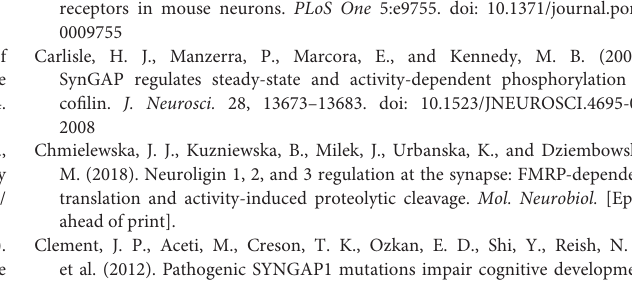
HET: N = 3) and PND21-23 ( right , WT: N = 3; HET: N = 3); NS, not significant. Unpaired Student’s t -test. FIGURE S5 | Dysregulated NMDAR-mediated translation response is recovered during PND21-23 in HET. (A) Representative immunoblot for Phospho-eEF2 and Total-eEF2 showing increased phosphorylation on NMDAR stimulation for 1-min in synaptoneurosomes from WT during PND21-23 ( left ). Pooled data of the same represented in the bar graph ( right, Basal: N = 4; Stimulated: N = 4); ∗ p < 0.05; Unpaired Student’s t -test. (B) Representative immunoblots of phospho- and total-eEF2 normalized to β -ACTIN during PND14-16 in WT and HET ( top ). The bar graph shows increased phosphorylation of eEF2 at basal conditions in synaptoneurosome obtained from the hippocampus of HET as compared to WT during PND14-16 in the ( middle, WT: N = 4; HET: N = 3). Bar graph showing decreased phosphorylation of eEF2 in HET on NMDAR stimulation as compared to WT in PND14-16 ( below, WT: N = 4; HET: N = 4). ∗ p < 0.05, ∗∗ p < 0.01; Unpaired Student’s t -test; WT and HET samples were run on the same gel; 1-min stimulation blots were cropped and showed here. (C) Representative immunoblots for phospho-eEF2 and total-eEF2 normalised to β -ACTIN during PND21-23 in WT and HET ( top ). Increased phosphorylation of eEF2 at the basal condition in HET synaptoneurosome as compared to WT during PND21-23 ( middle , WT: N = 3; HET: N = 3). Bar graph showing the extent of phosphorylation in HET is similar to WT during PND21-23 ( bottom , WT: N = 3; HET: N = 4). ∗ p < 0.05, NS, not significant; Unpaired Student’s t -test. (D) Representative immunoblot for Phospho-ERK1/2 and Total-ERK1/2 showing increased phosphorylation on NMDAR stimulation for 5-min in synaptoneurosomes from WT and HET during PND14-16 ( left ). Pooled data of the same represented in the bar graphs ( right, Basal: N = 4; Stimulated: N = 4); ∗ p < 0.05; Unpaired Student’s t -test. FIGURE S6 | Altered phosphorylation of eEF2 in HET. (A) Representative immunoblot depicting the enrichment of PSD-95 in synaptoneurosome (S) compared to Total hippocampal lysate (T; top ). A bar graph is showing quantified data normalised to α -TUBULIN ( below ). (B) Representative immunoblot for Phospho-eEF2, Total-eEF2, and β -ACTIN in synaptoneurosomes after 1-min stimulation with NMDA, AP-5, and NMDA + AP-5 ( top ). Quantified data as histogram shows increased phosphorylation of eEF2 on NMDA treatment is lost when co-treated with AP-5 ( below ). ∗ p < 0.05, One-way ANOVA followed by Dunnett’s multiple comparison tests. (C) Representative immunoblot images for Phospho-eEF2, Total-eEF2, and β -ACTIN in synaptoneurosomes after 1-min and 2-min NMDAR stimulation during PND14-16 ( top ). All samples (both WT and HET) were run on the same gel (B: Basal; N: NMDA stimulation). 1-min stimulation bands were cropped and represented in Supplementary Figure S5 . Bar graph showing that a 2-min activation of NMDAR alters phosphorylation of eEF2 in HET ( N = 3) compared to WT ( N = 3) in PND14-16 ( below ). ∗ p < 0.05; NS, not significant. Unpaired Student’s t -test. (D) Representative immunoblot for Phospho- and Total-eEF2 normalized to β -ACTIN synaptoneurosomes stimulated with NMDA for 2-min in WT and HET during PND21-23 ( top ). Bar graph depicting unaltered phosphorylation of eEF2 in HET ( N = 3) compared to WT ( N = 3) post-2-min activation of NMDAR. NS, not significant. Unpaired Student’s t -test. (E) Representative immunoblots of phospho- and total-eEF2 normalized to β -ACTIN during PND > 60 in WT and HET ( left ). Bar graph showing decreased phosphorylation of eEF2 in HET on NMDAR stimulation as compared to WT in PND > 60 ( right, WT: N = 4; HET: N = 4). ∗ p < 0.05; Unpaired Student’s t